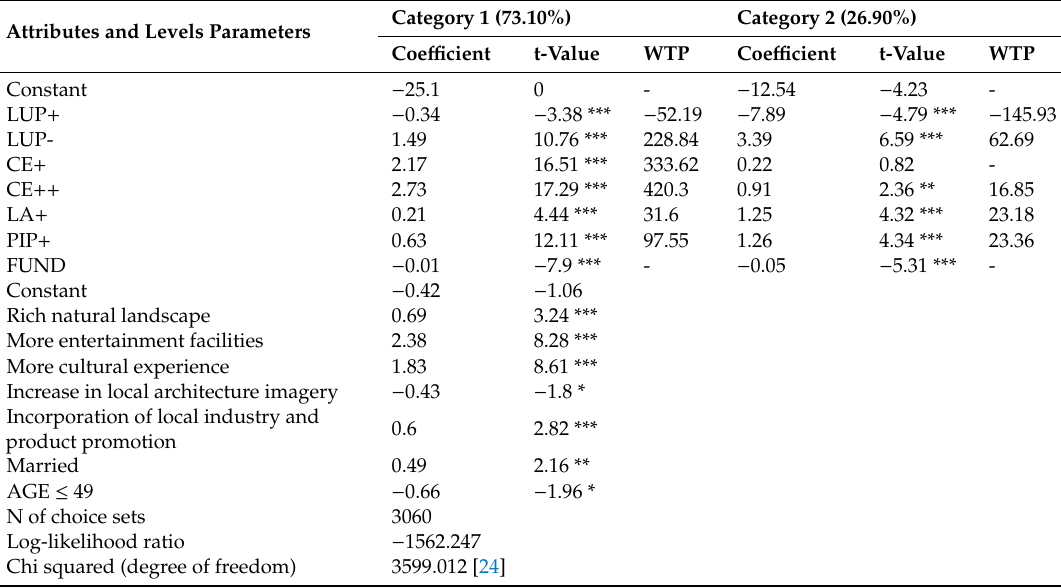
Table 7. Empirical projection results on potential category